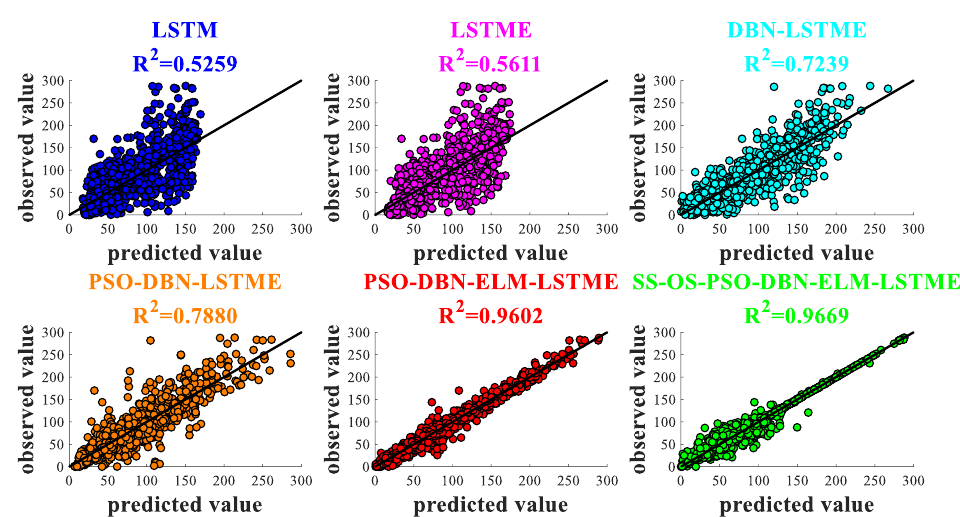
Figure 12. Scatter plots of observed and predicted rainfall (unit: mm) using M1 − M6 models.